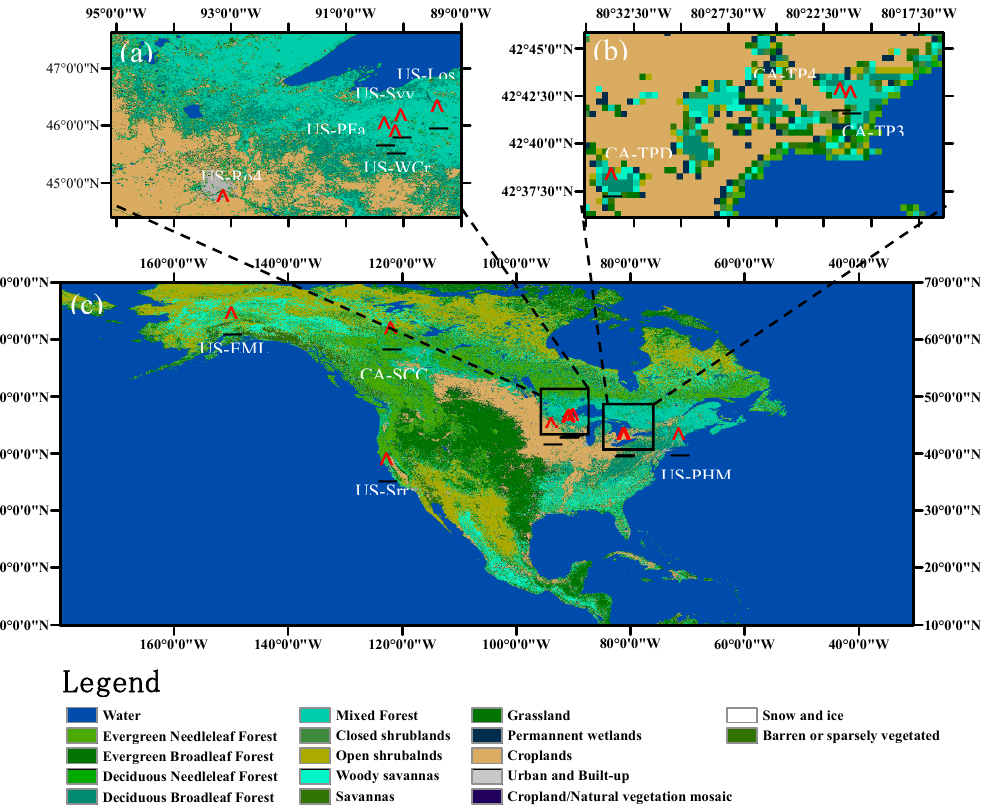
Figure 1. Location and attribute of selected EC sites. ( a ) An enlarged image showing sites of US-PFa, US-Syv, US-WCr, US-Los and US-Ro4. ( b ) An enlarged image showing sites of CA-TP3, CA-TP4 and TPD. ( c ) The location map of the study area; the five-pointed star indicates the location of the study area, and the base map is created in ARCGIS using MCD12Q1 data. Table 1. Detailed information of eddy covariance (EC) Flux Towers, including site’s name, latitude, longitude, the year of data used and its institution (ENF: Evergreen Needleleaf Forests, DBF: Deciduous Broadleaf Forests, GRA: Grasslands, OSH: Open shrublands, MF: Mixed Forest, WET: Permeland Wetlands).